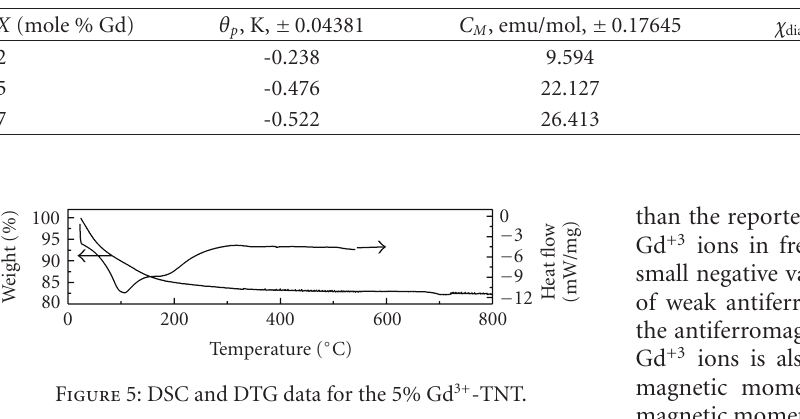
Table 1: Magnetic parameters of x Gd-(100- x ) H 2 Ti 5 O 11 ( x % Gd 3+ -TNTs) where ( x = 2,5,7).